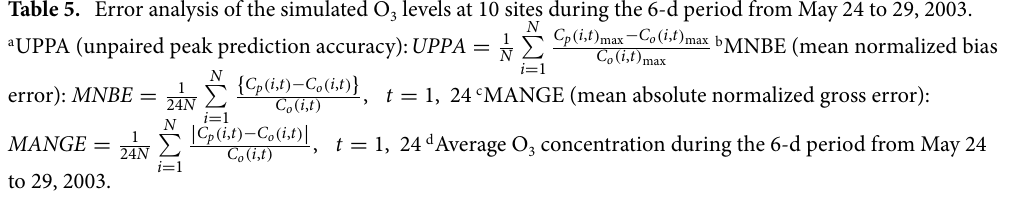
, t = 1, 24 d Average O 3 concentration during the 6-d period from May